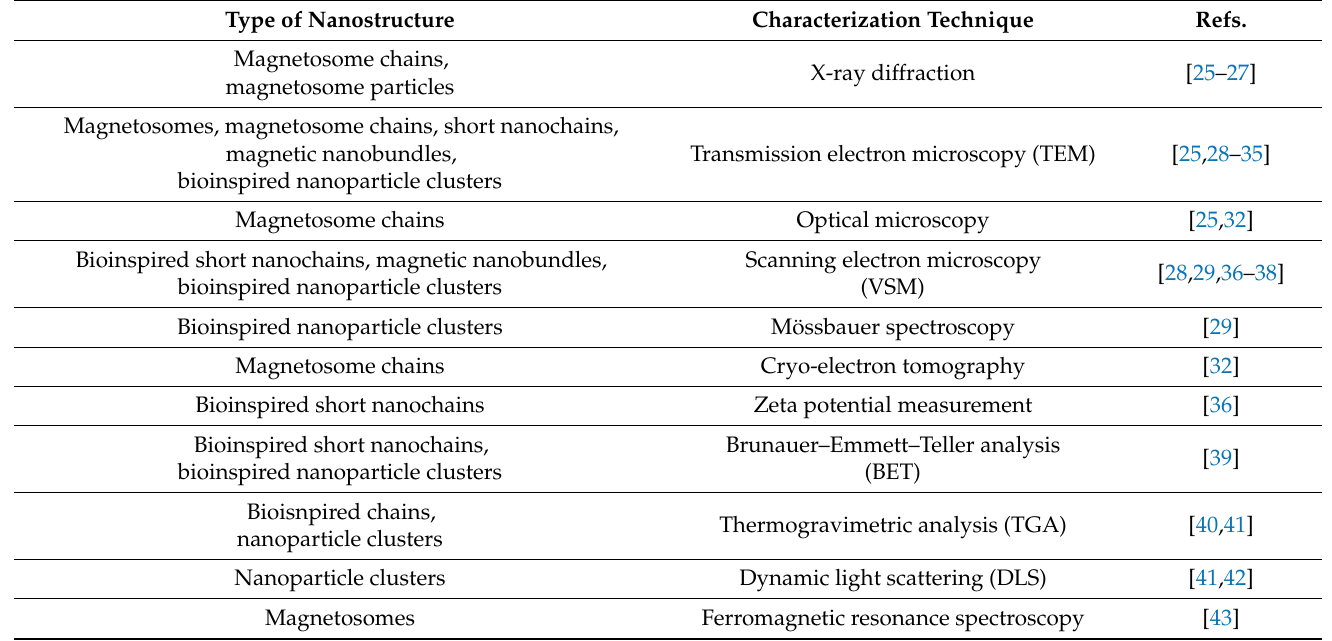
Table 1. Characterization techniques for magnetic nanostructures